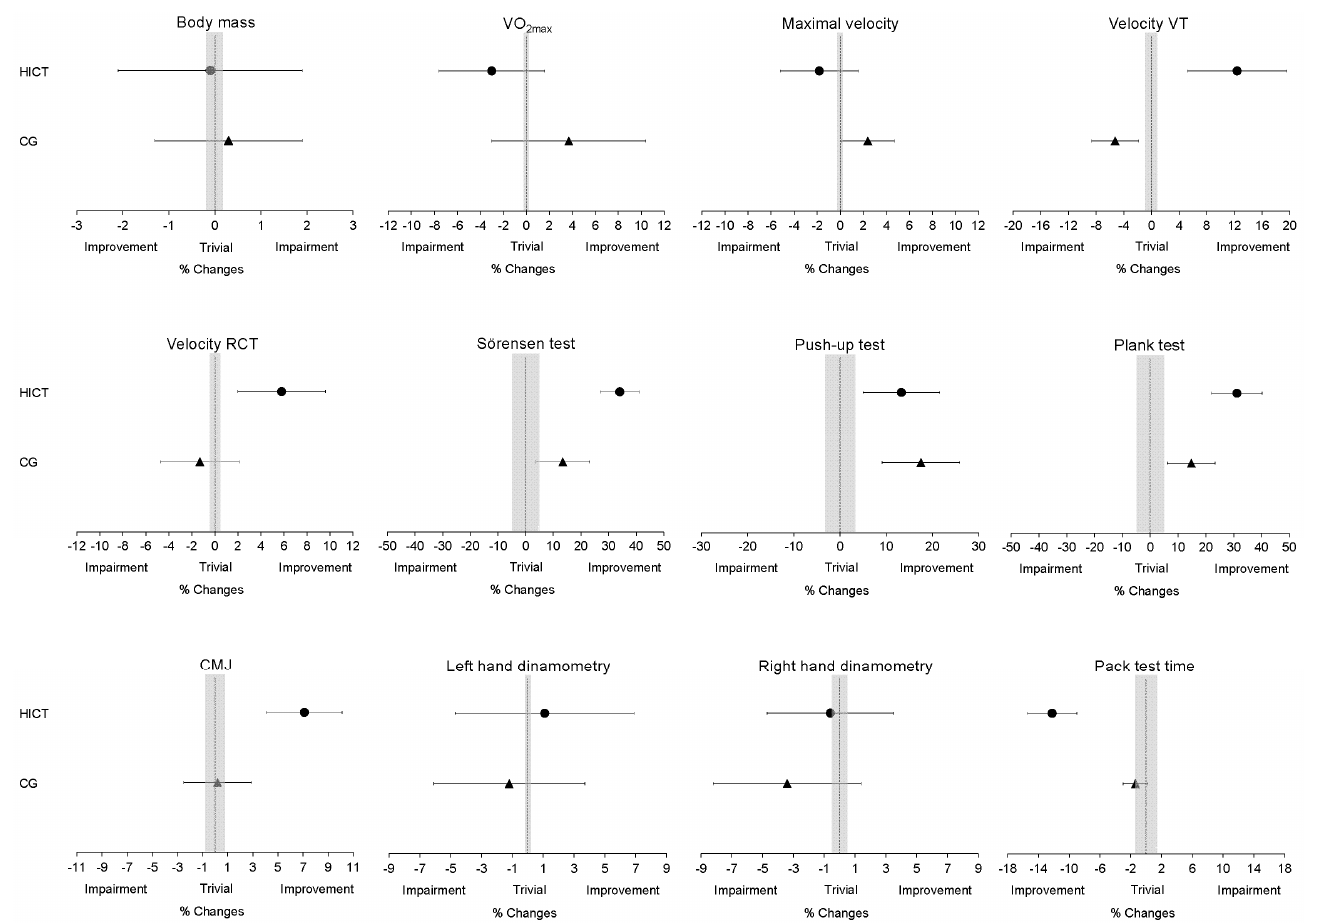
Figure 1. Relative changes for tests’ performance in the high-intensity circuit training group (HICT)